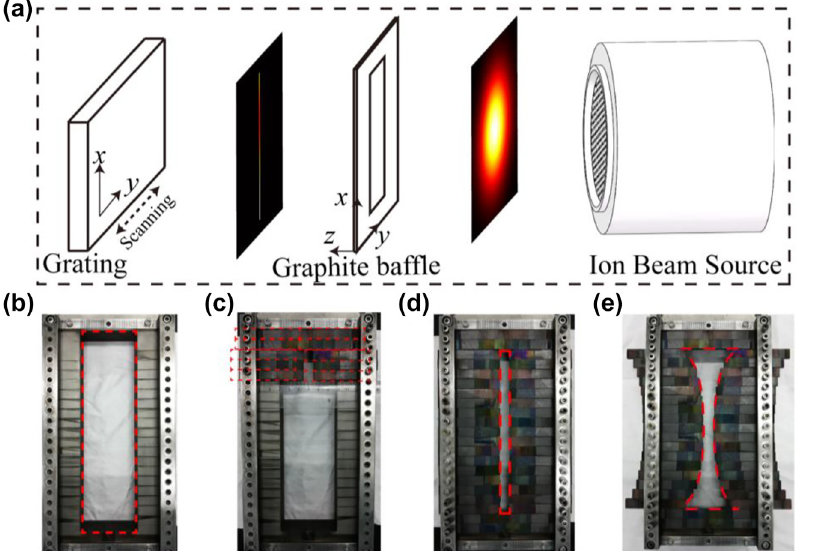
Figure 4: Scanned reactive-ion-beam etching method. (a) Schematic of scanned reactive-ion-beam etching for large-area grating. (b) Photograph of the graphite baffle holder. Red-dotted box indicates the opening area of the holder structure. (c) Adjusting the graphite plates, as shown by red-dotted box to change the shape of the graphite baffle. (d) Rectangular and (e) hyperbolic graphite